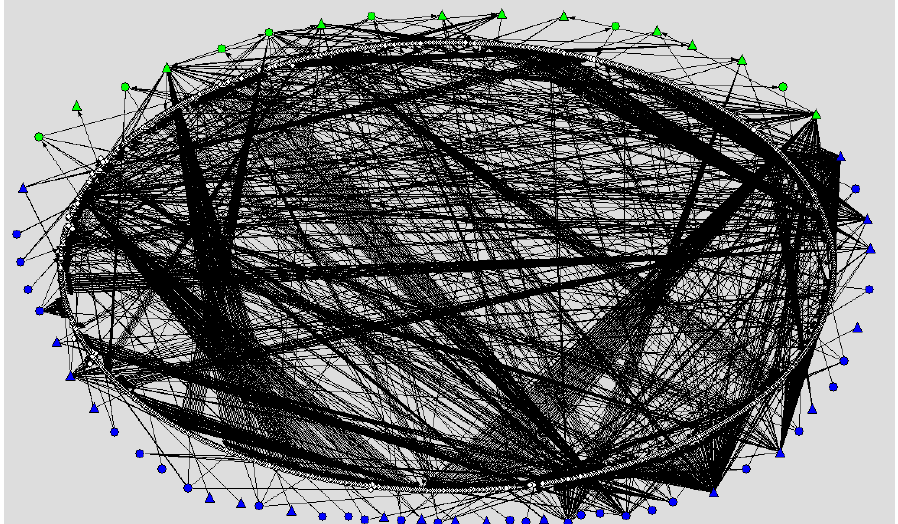
Figure 1. The Transcriptional-Regulatory Network of M. tuberculosis . Nodes represent Mt ’s genes, and links represent their regulatory interactions. Transcription factors appear either green or blue, depending on whether they have known transcriptional regulators or not. The white nodes represent output elements without transcriptional activity. The triangle nodes represent protein transcription factors that auto-regulate their own expression. Approximately 35% of the genome is covered by this network. (Modified from